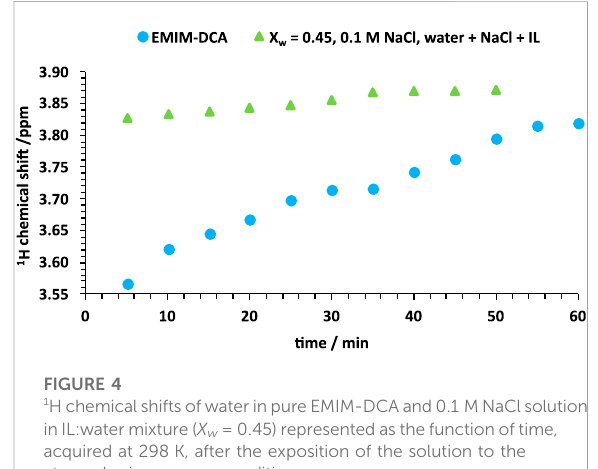
FIGURE 4 1 Hchemical shiftsofwaterinpureEMIM-DCAand0.1 MNaClsolution inIL:water mixture( X w = 0.45)represented as thefunction oftime, acquired at 298 K, after the exposition of the solution to the atmospheric pressure